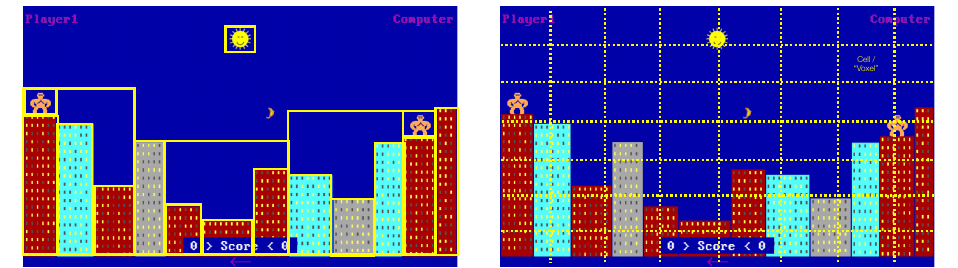
Figure 2. Visualisation of typical acceleration structures, using an analogy to a 2D computer game. (Left:) Hierarchy of bounding boxes, which can be constructed from the most elementary bounding boxes. (Right:) A simple cell / grid structure in which each cell can store information about its local